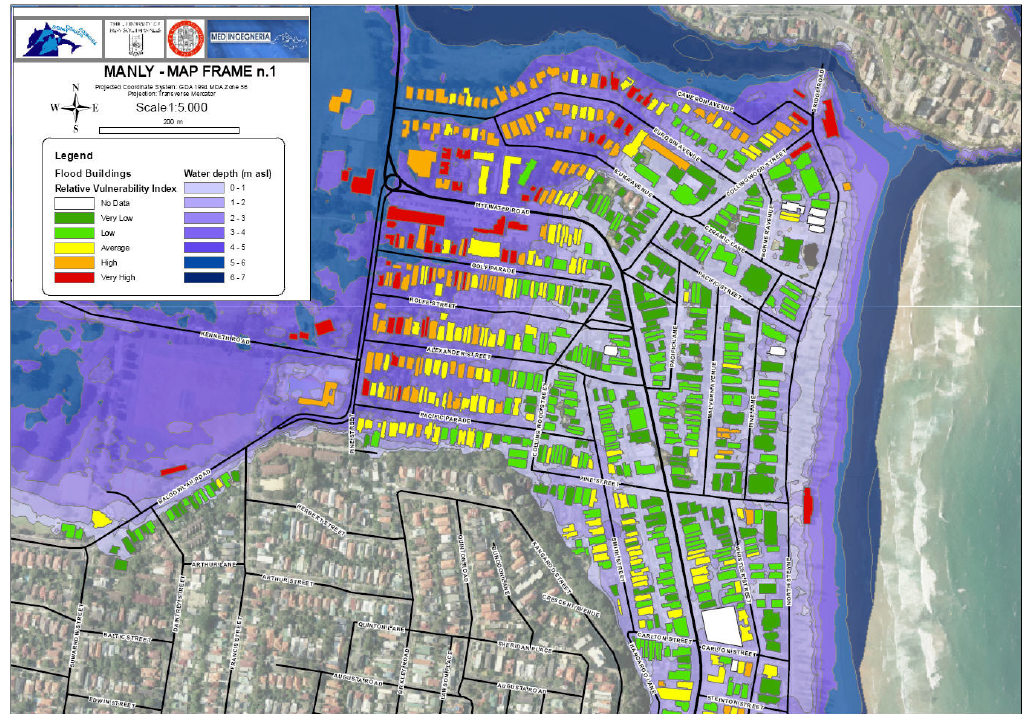
Fig. 3. Tsunami inundation and water depth in the northern part of Manly (Map Frame n. 1). The RVI scores of every building located within the inundation zone are indicated.